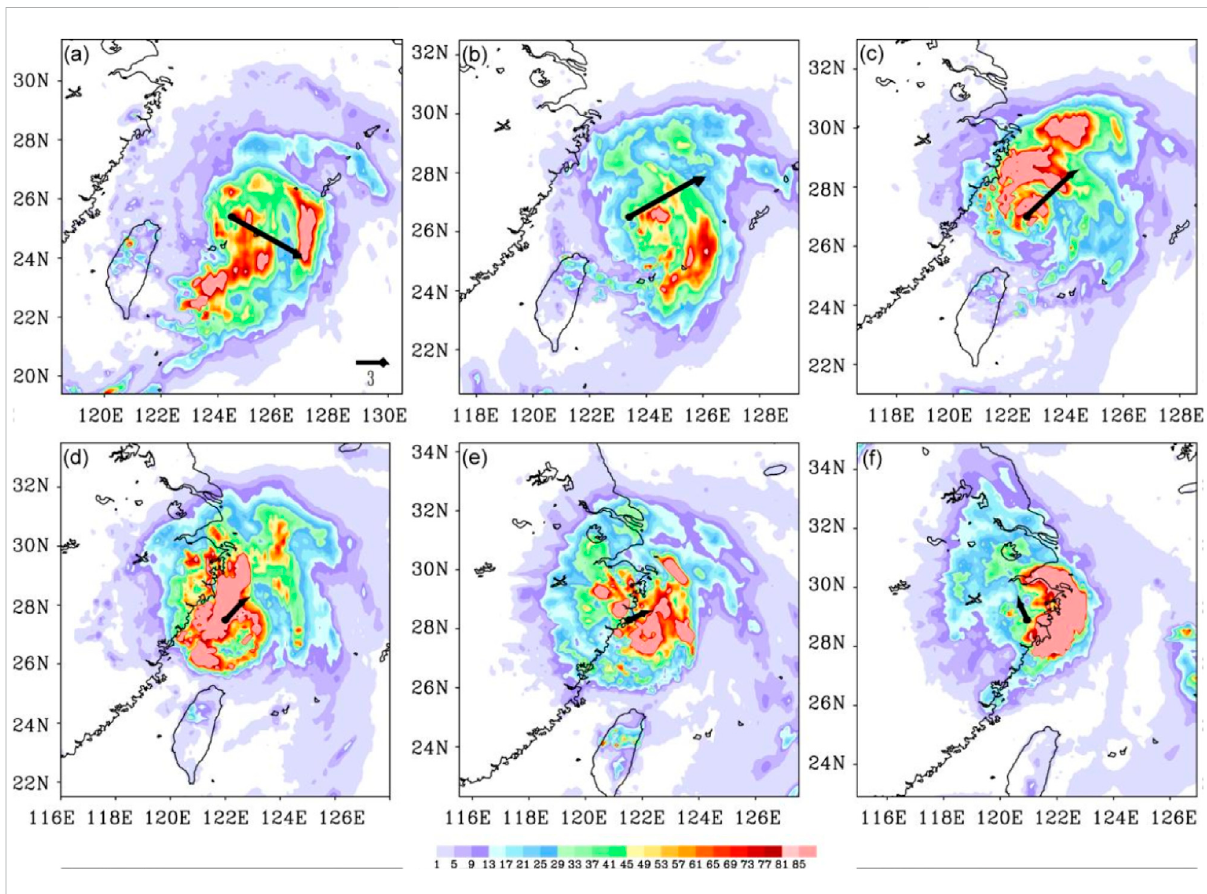
FIGURE 2 Six-hour accumulated precipitation of GPM (unit: mm) at (A) 18:00 UTC on 8 August 2019, (B) 00:00 UTC on 9 August 2019, (C) 06:00 UTC on 9 August 2019, (D) 12:00 UTC on 9 August 2019, (E) 18:00 UTC on 9 August 2019, and (F) 00:00 UTC on 10 August 2019. The black arrow denotes VWS between 200 and 850 hPa (reference magnitude in a), with black dots indicating the center of